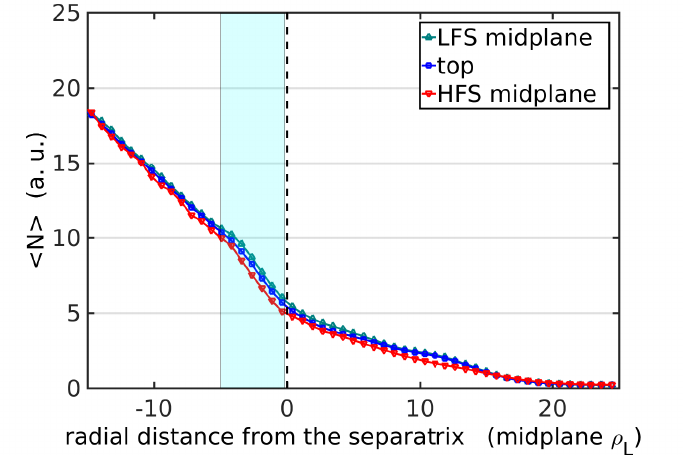
Figure 5. Radial profiles of the density averaged over time and toroidal direction, for a COMPASS-like diverted geometry. The profiles are taken at the LFS midplane, at the top of the plasma (top), and at the High-Field Side (HFS) midplane. In evidence, the region affected by the